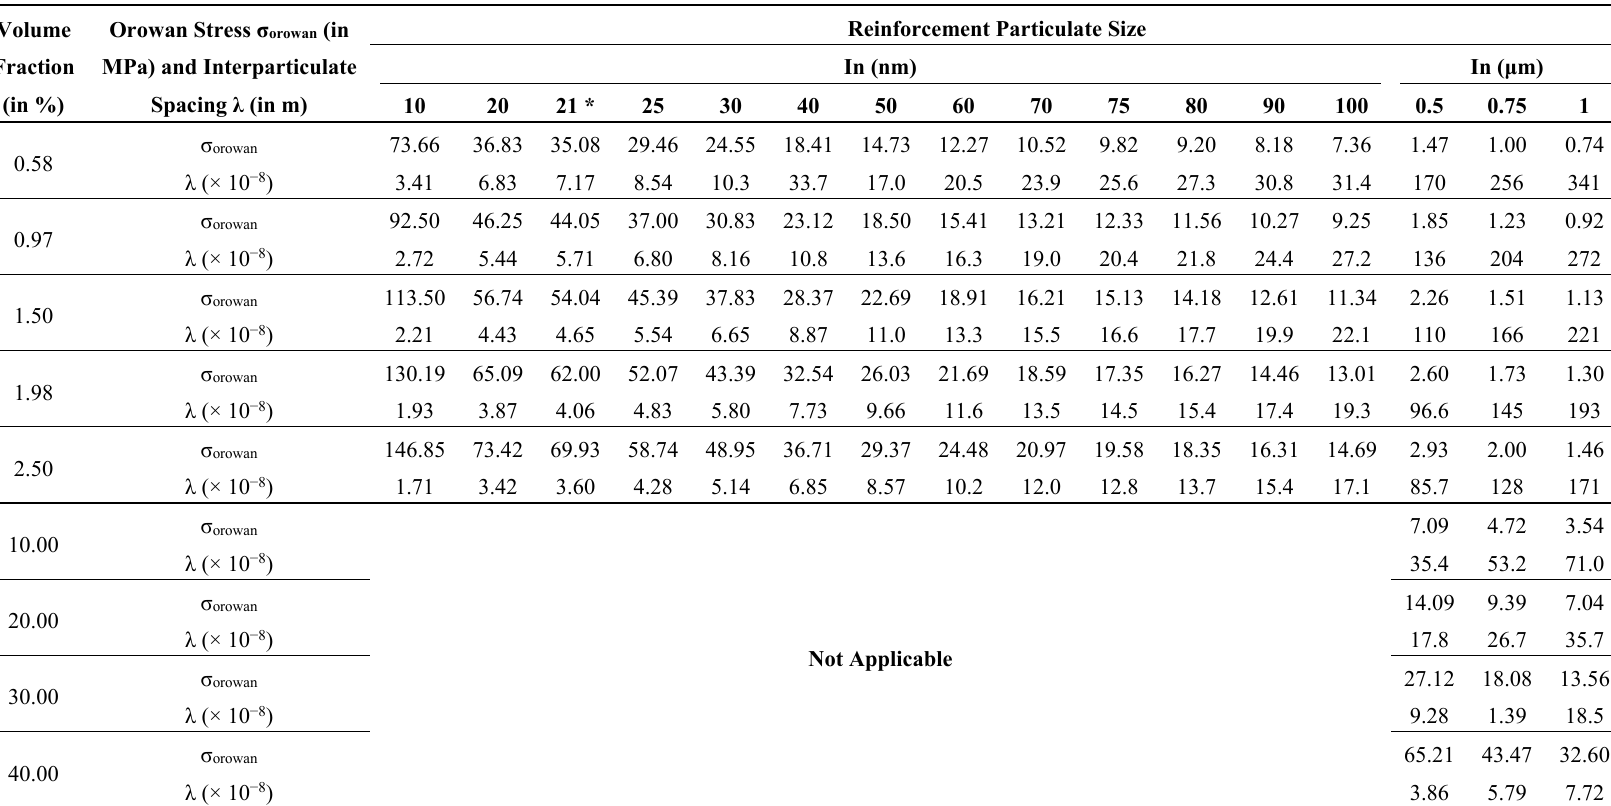
Table 7. Designing of Mg composites based on contribution of Orowan strengthening calculated by using Orowan- Ashby equation